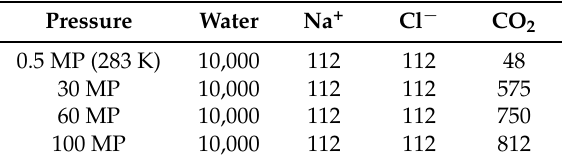
Table 1. The number CO 2 and NaCl molecules used in the aqueous solution at 275 K. Pressure Water Na + Cl − CO 2 0.5 MP (283 K) 10,000 112 112 48 30 MP 10,000 112 112 575 60 MP 10,000 112 112 750 100 MP 10,000 112 112 812